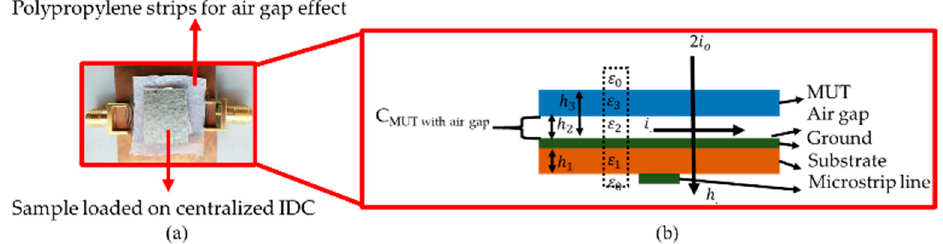
Figure 4. ( a ) Designed sensor under testing with polypropylene strip between the testing specimen and resonator and ( b ) dimension of the mapping air gap scenario between MUT and resonator. Figure 4b represents the different heights ( h 1 , h 2 , h 3 ), where h 1 is the substrate